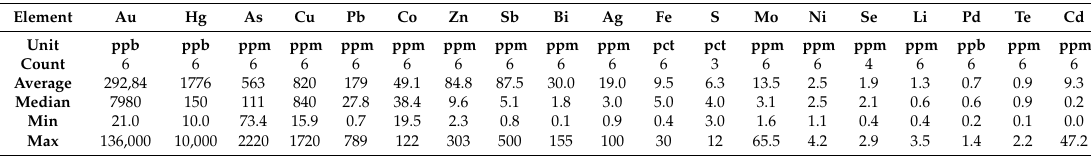
Table 3. Whole-vein summary statistical analysis of Au, Hg, As, Cu, Pb, Co, Zn, Sb, Bi, Ag, Fe, S, Mo, Ni, Se, Li, Pd, Te, Cd, Pt, In, and Re from quartz veins from Mollehuaca and San Juan de Chorunga, Arequipa-Per ú ( n = 6).